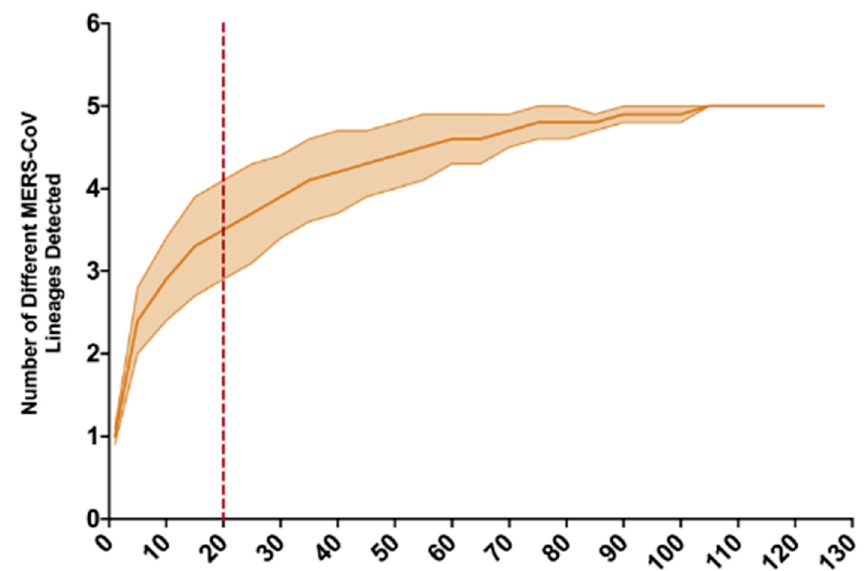
Figure 3. Rarefaction analysis of lineage assignment for 129 camel-derived full MERS-CoV genome sequences from a large camel market in UAE, as reported in Yusof et al., 2018. The envelope reflects variance, and the red dashed line at 20 samples reflects the number of MERS-CoV sequences recovered in this study, all of which belong to lineage B.5.